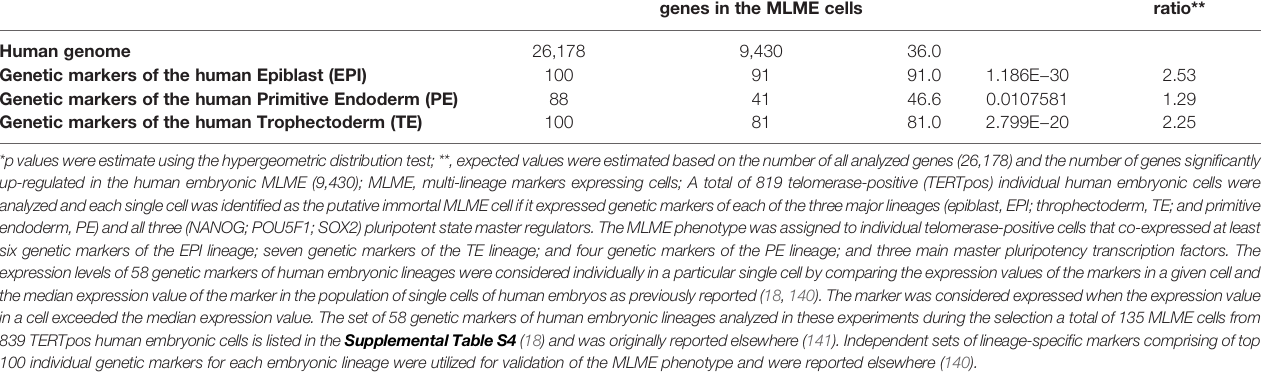
TABLE 1 | Enrichment of genes comprising top 100 lineage-speci fi c genetic markers of each of three major embryonic lineages of human preimplantation embryos among genes that are signi fi cantly up-regulated in the MLME cells. Classi fi cation